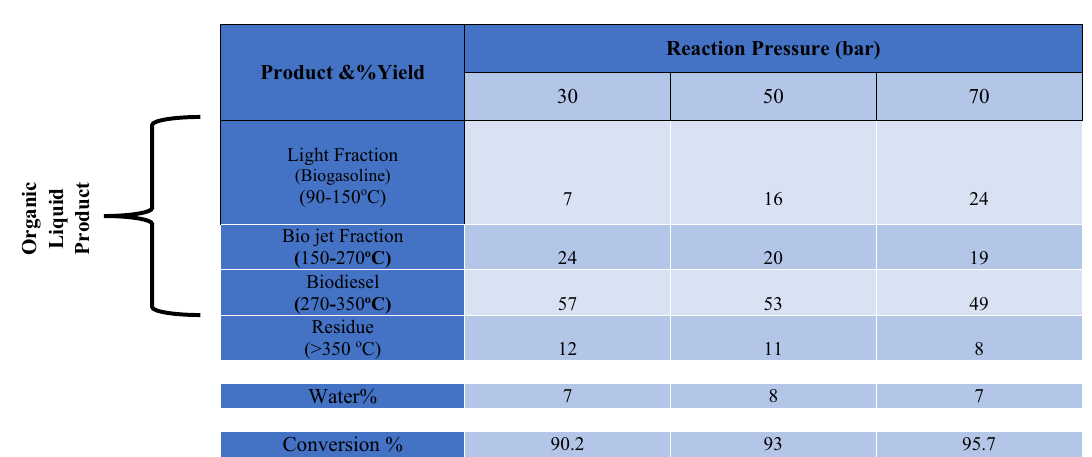
Table 4. Effect of Operating Pressure on Hydro-conversion of WCO over CoAl 2 O 4 Nanoparticles. (Temperature 400 °C, LHSV: 1 h -1